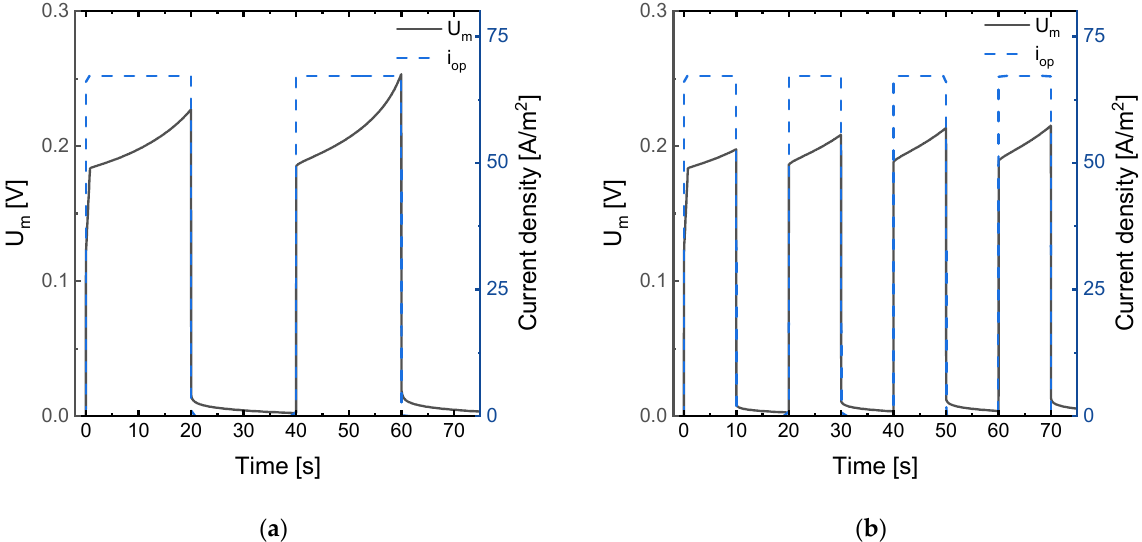
Figure 6. Evolution with time of the membrane system potential drop ( U m ) under the application of 1.2 · i lim in PEF mode with α = 0.5 and ( a ) pulse frequency f = 0.025 Hz ( t on = 20 s, t off = 20 s); and ( b ) pulse frequency f = 0.05 Hz ( t on = 10 s, t off = 10 s).